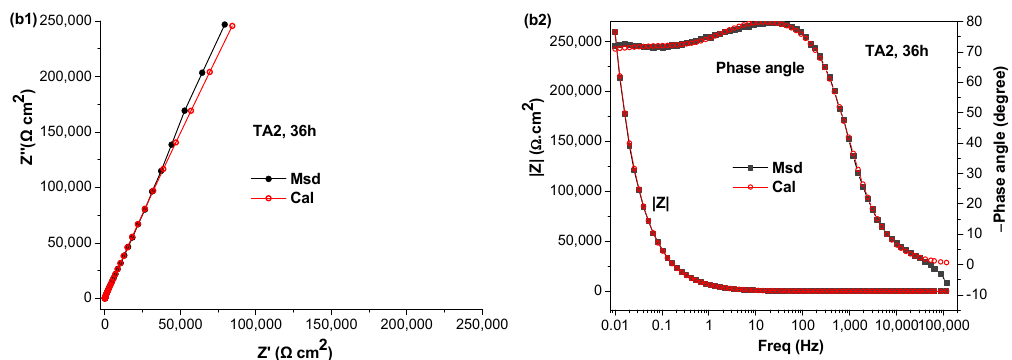
Figure 11. Fitting Nyquist and Bode graph of EIS spectra of ( a1 , a2 ) MAO-1-2# and ( b1 , b2 ) untreated TA2 after 36 h immersion in 3.5%NaCl solution. Equivalent circuit model R s ( Q p ( R p ( Q b ( R b Q d )))) and R s ( Q b ( Q d R b ) were used to fit the spectrum of MAO-1-2# and bare TA2 specimens, respectively.